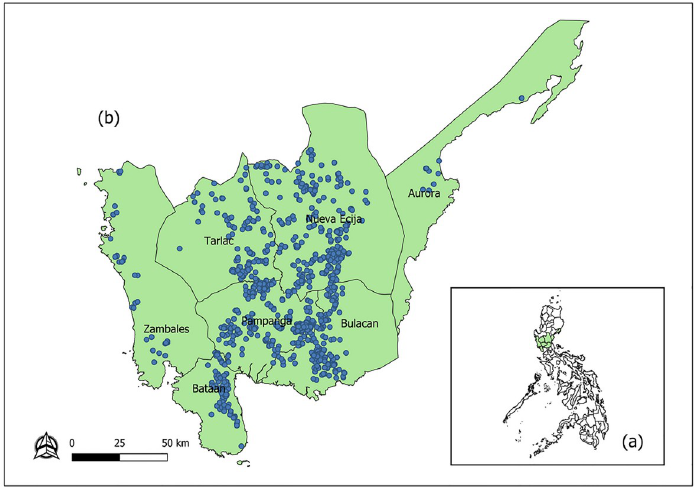
Fig 1. Geographic distribution of poultry farms in central Luzon (CL) in 2018. (a) map of Philippines showing the location of Central Luzon (CL) in green. (b) distribution of highly pathogenic avian influenza susceptible farms in the seven provinces of